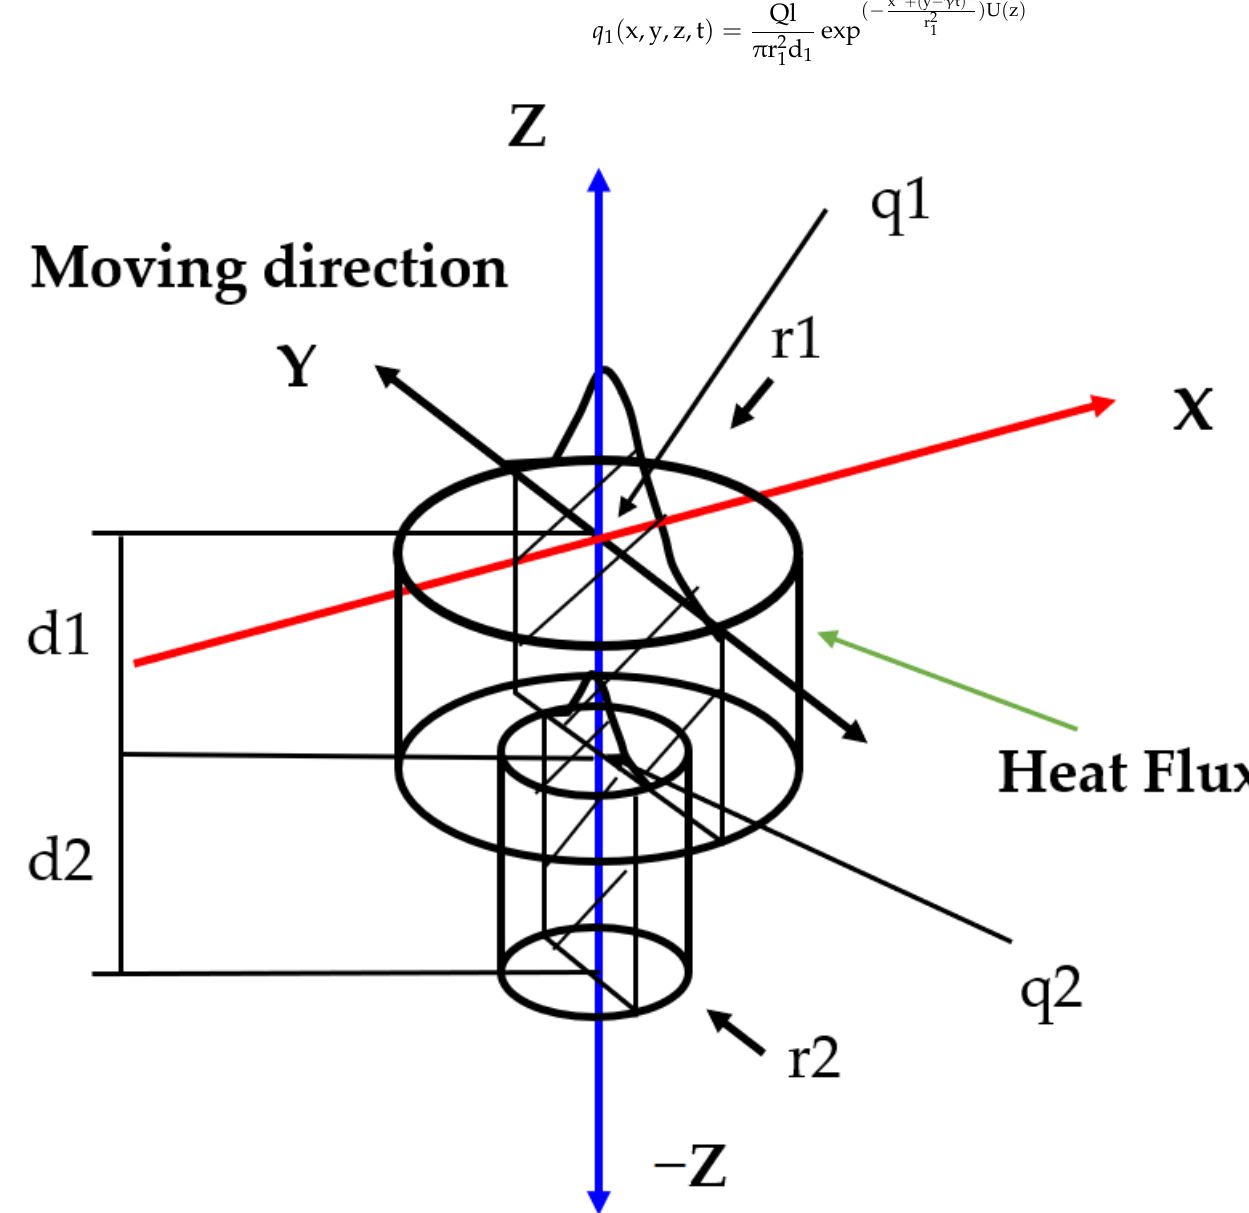
Figure 3. Stepped cylindrical Gaussian distribution model.